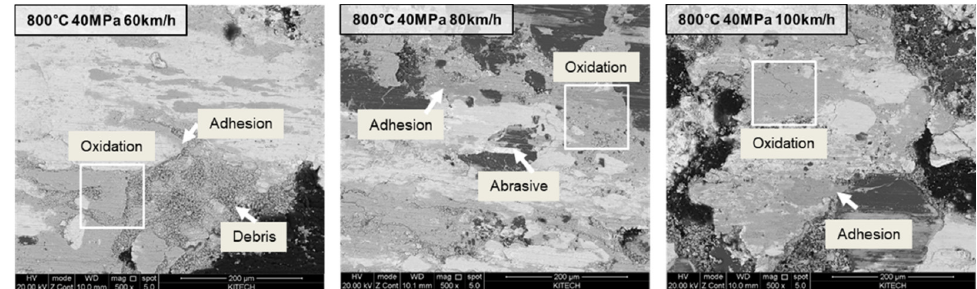
Figure 13. BSE images of worn surface of Cu-based brake pad after dynamometer test performed at speeds of 60, 80, and 100 km/h.